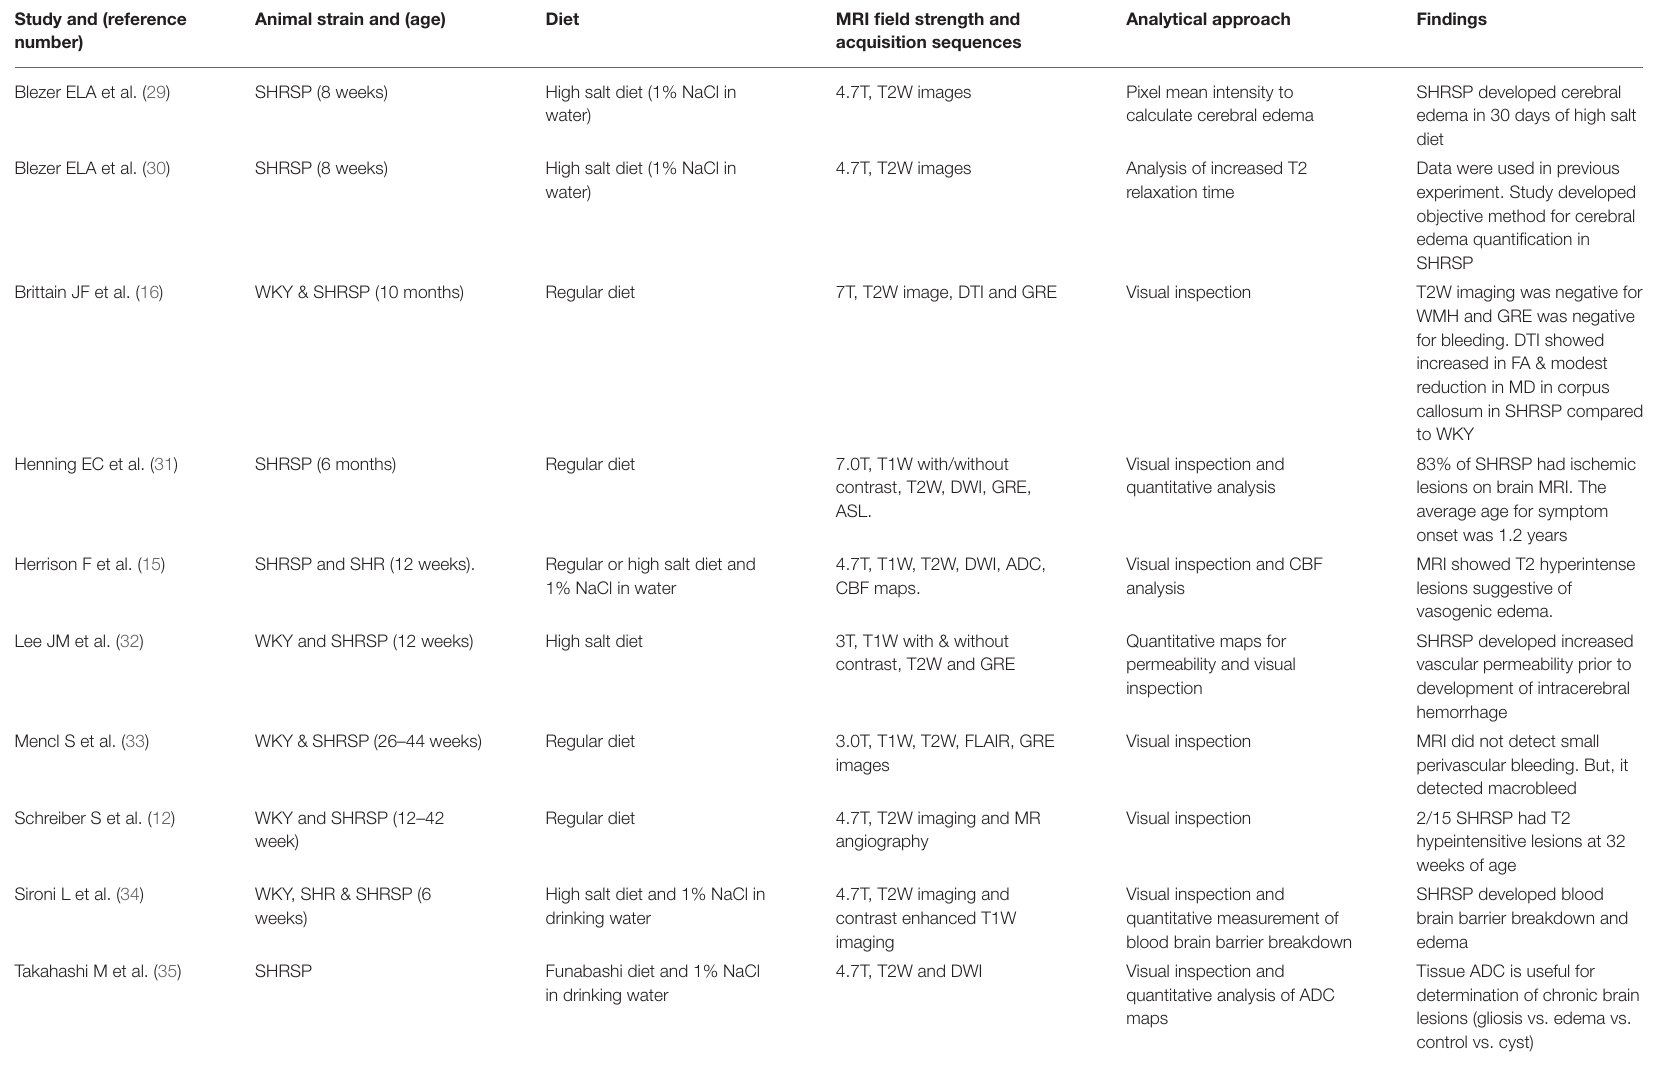
TABLE 1 | Previous literature assessing cerebral small vessel disease findings on brain MRI in